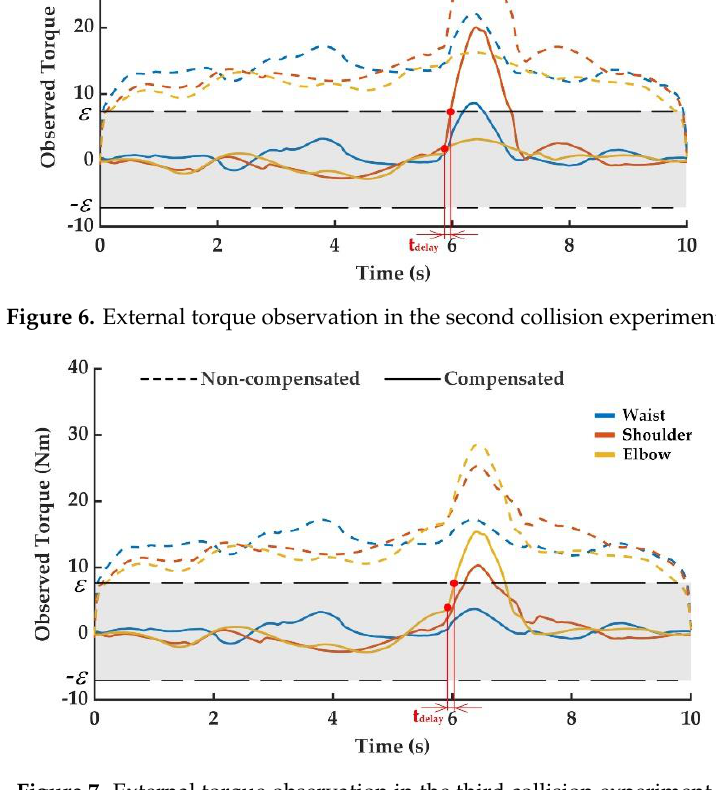
Figure 7. External torque observation in the third collision experiment.